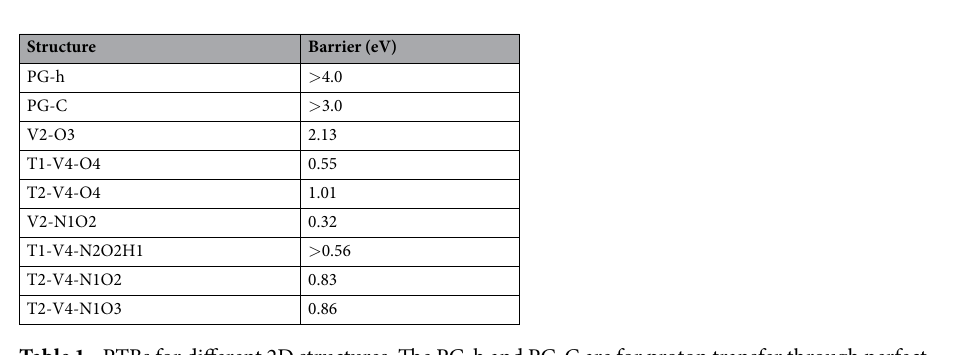
Table 1. PTBs for different 2D structures. The PG-h and PG-C are for proton transfer through perfect graphene. More details are in Supporting Information